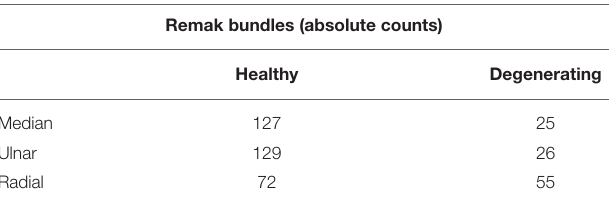
TABLE 5 | Absolute counts of healthy and degenerating Remak bundles (groups of small unmyelinated C fibers) in all nerves in our study. Remak bundles (absolute